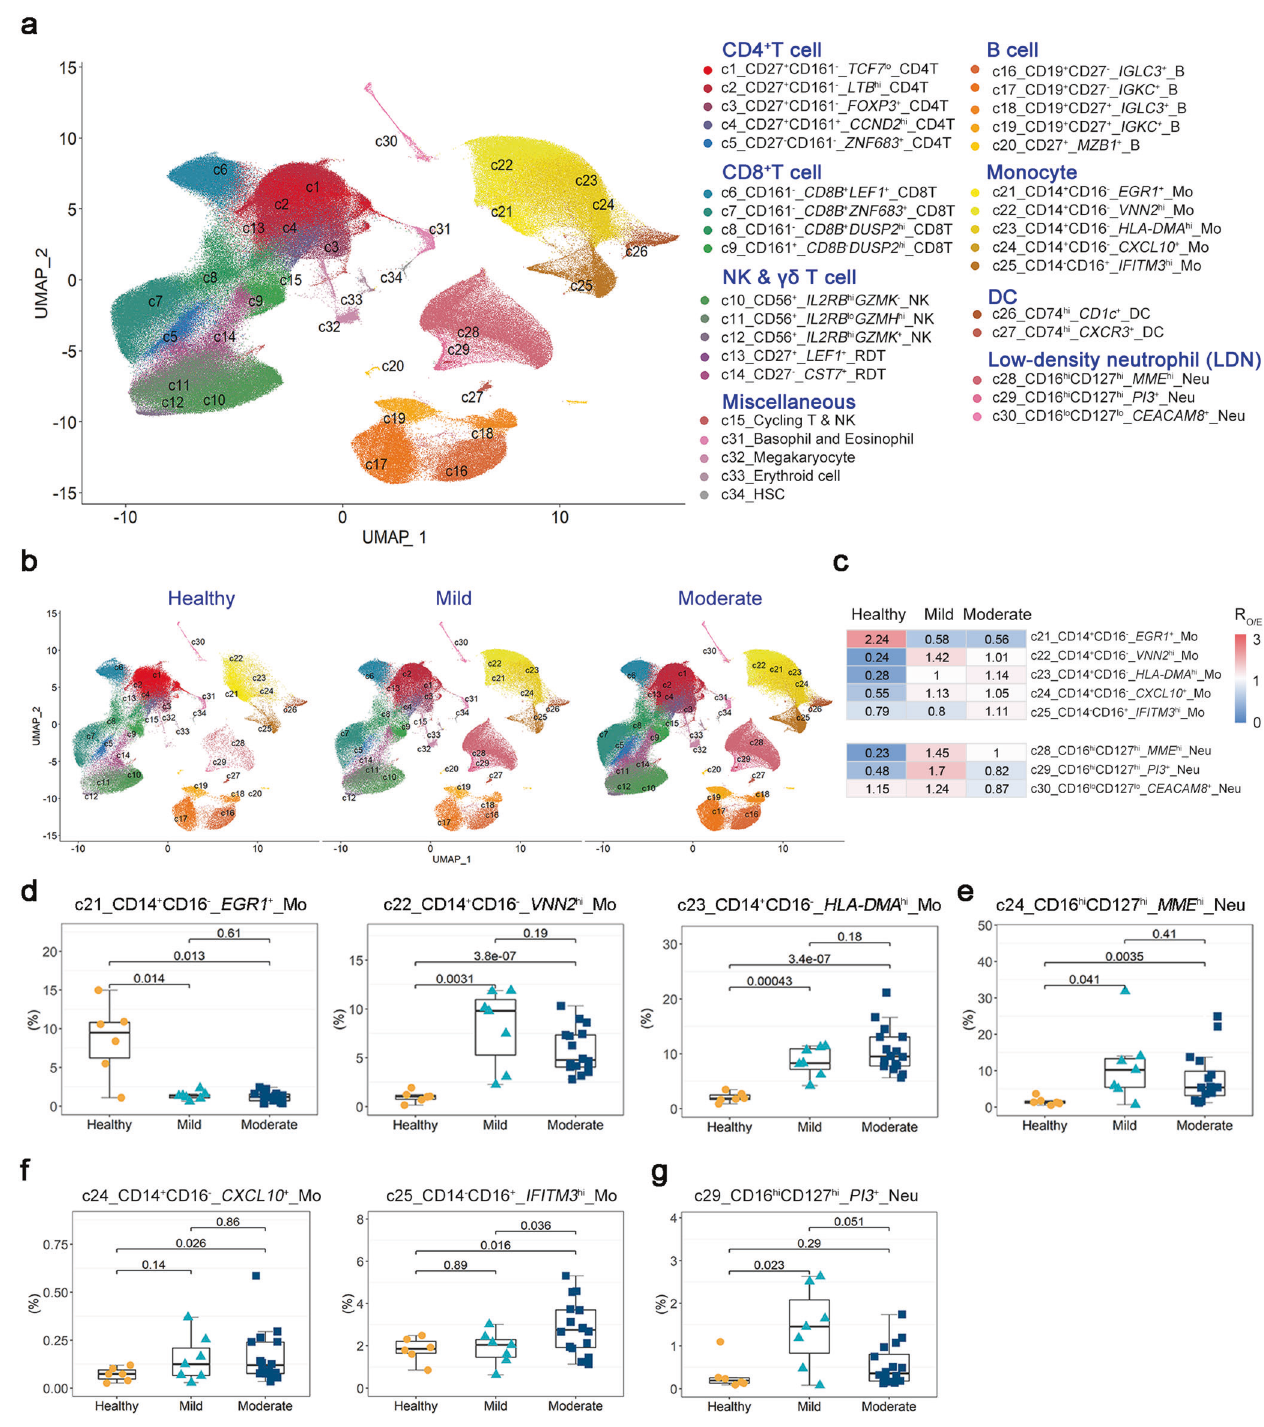
Fig. 2 The peripheral immune cell pro fi ling of the Omicron variant-infected convalescents and healthy donors. a UMAP plots showing all the 34 cell clusters in peripheral blood from convalescents with mild to moderate Omicron infection and healthy controls. Clusters were named based on the cluster-speci fi c expression patterns at protein and transcript levels, followed by the major cell type. See also Supplementary Fig. S3, S4 and Table. S4. b UMAP plots showing the cell clusters in PBMCs from the Omicron convalescents experienced mild or moderate clinical symptoms and healthy controls. c The composition of monocytes and low-density neutrophils (LDNs) measured by the ratio of observed to randomly expected cell numbers (R O/E ) in PBMCs from the Omicron convalescents ( n = 7 for mild and n = 16 for moderate) and healthy controls ( n = 6). d The composition of monocytes measured by percentages in PBMCs from the Omicron convalescents and healthy controls. t -test with Welch ’ s correction. e The composition of LDNs measured by percentages in PBMCs from the Omicron convalescents and healthy controls. t -test with Welch ’ s correction. f The composition of monocytes measured by percentages in PBMCs from the moderate convalescents and healthy controls. t -test with Welch ’ s correction. g The composition of LDNs measured by percentages in PBMCs from the mild convalescents and healthy controls. t -test with Welch ’ s correction